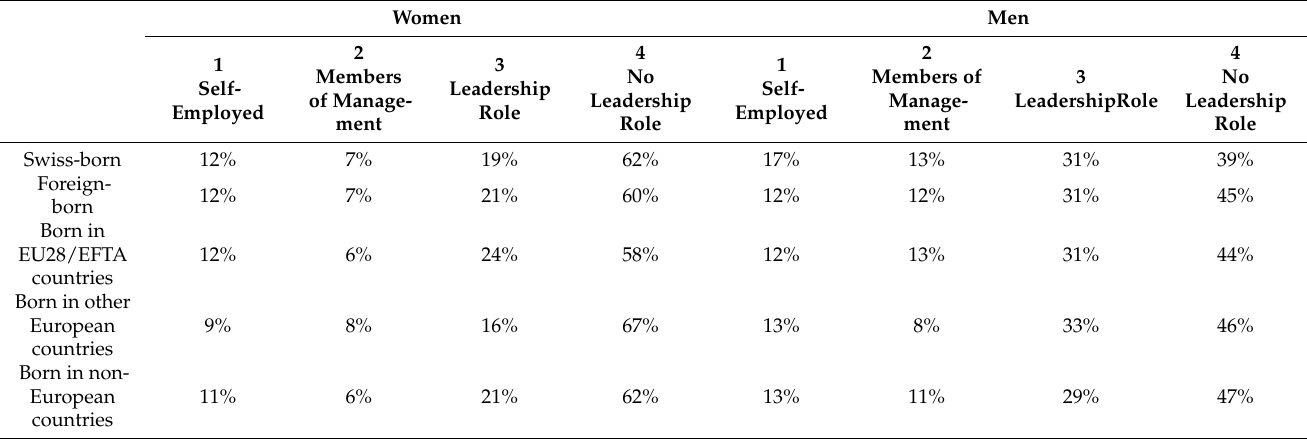
Table 5. Employment Status of Tertiary-Educated Professionals by Gender and Country of Birth, Switzerland (15–60 years old),